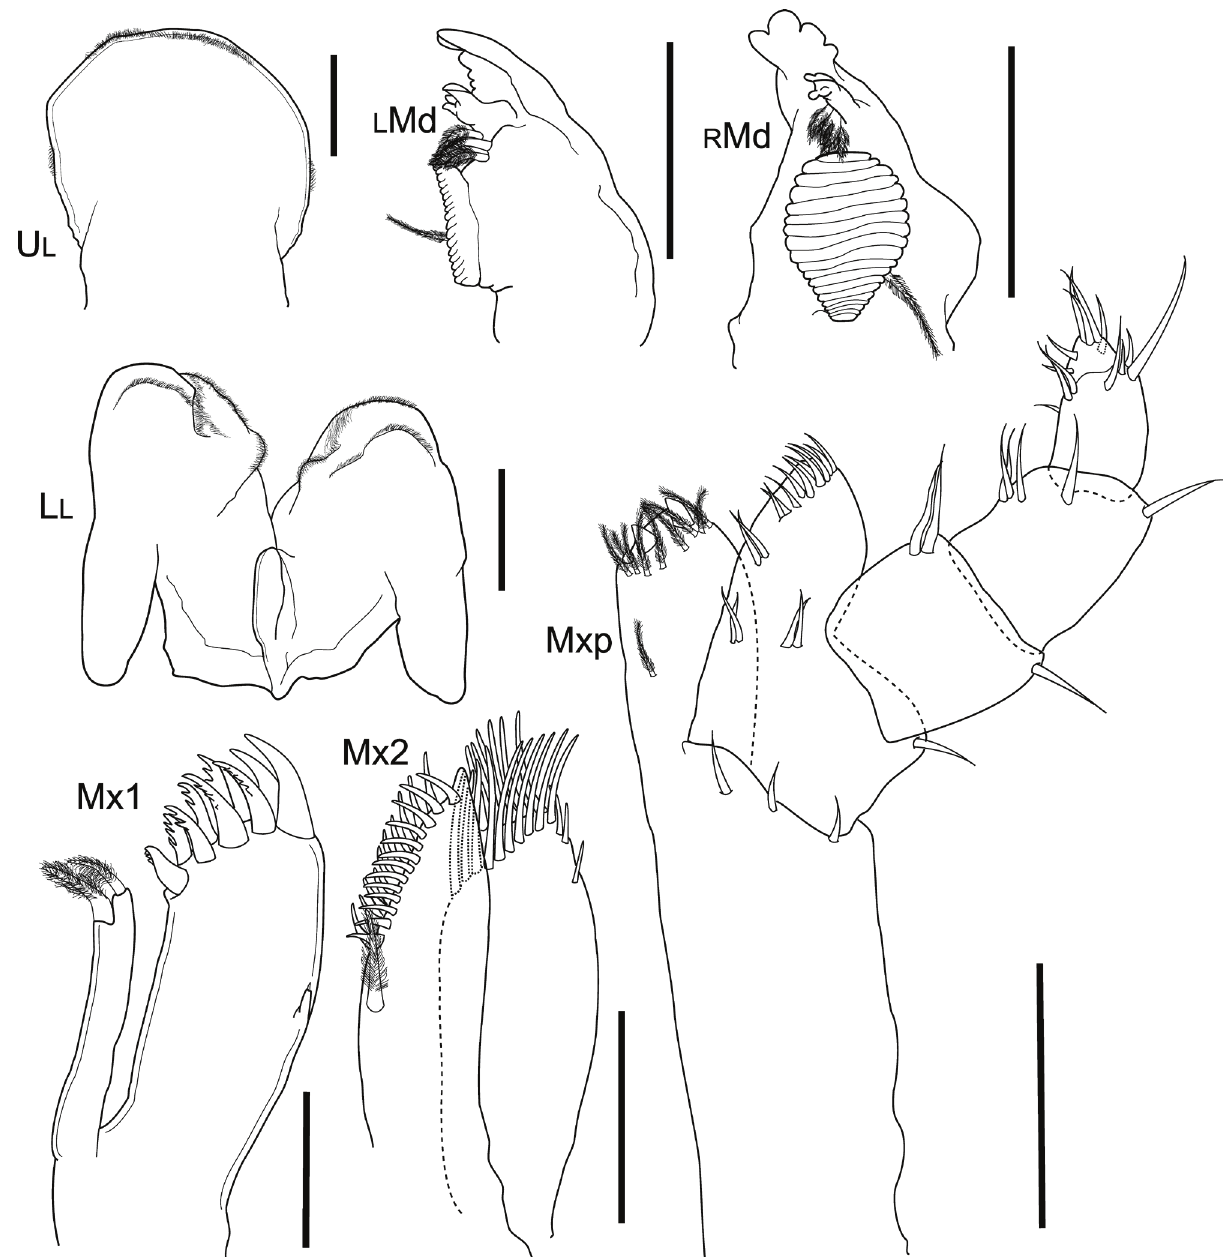
Figure 1. Talitroides alluaudi (Chevreux, 1896). Female 6.2 mm, MNRJ 9717: Mouthparts. Scales = 0.1